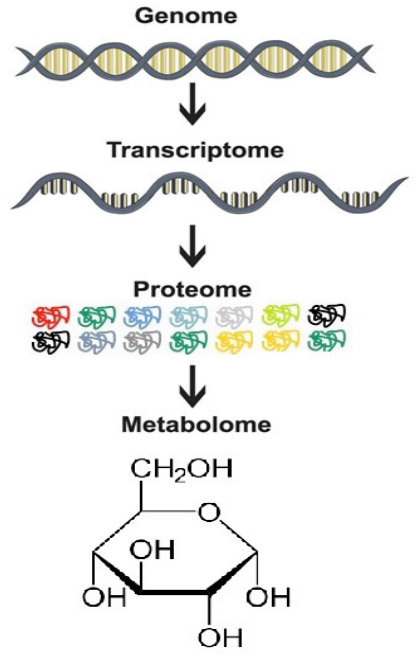
Figure 1. The omics cascade. The metabolome represents the final step of the omics cascade and is downstream of the proteome. Any alteration in the metabolome triggered by drug treatment would therefore provide information on the effects of the drug.